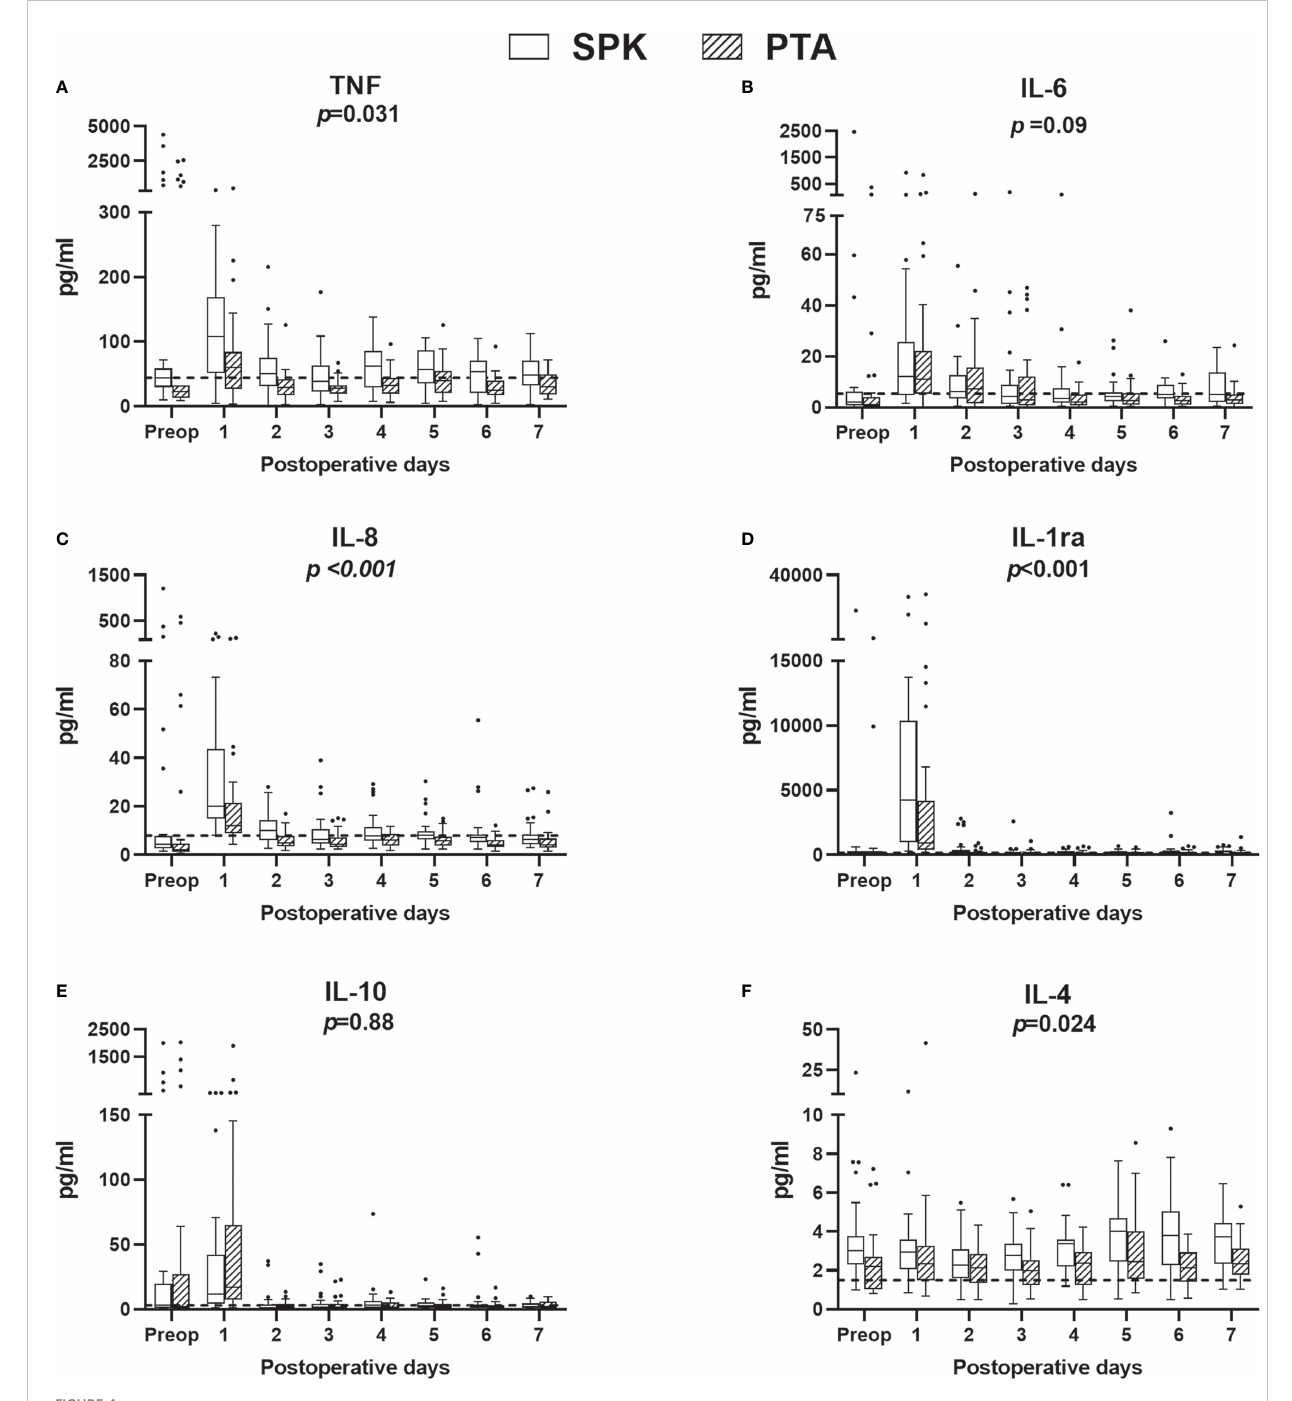
FIGURE 4 Plasma concentrations of proin fl ammatory (A – C) and anti-in fl ammatory (D – F) cytokine preoperatively (preop) and during the fi rst postoperative week, for simultaneous pancreas-kidney (SPK) (n=35) transplantation and pancreas transplant alone (PTA) (n=32) patients. Boxplots, reference lines, and overall effects of transplantation group are calculated and presented as in Figure 2. IL, interleukin; IL-1ra; interleukin-1 receptor antagonist; pg, picogram; TNF, tumor necrosis